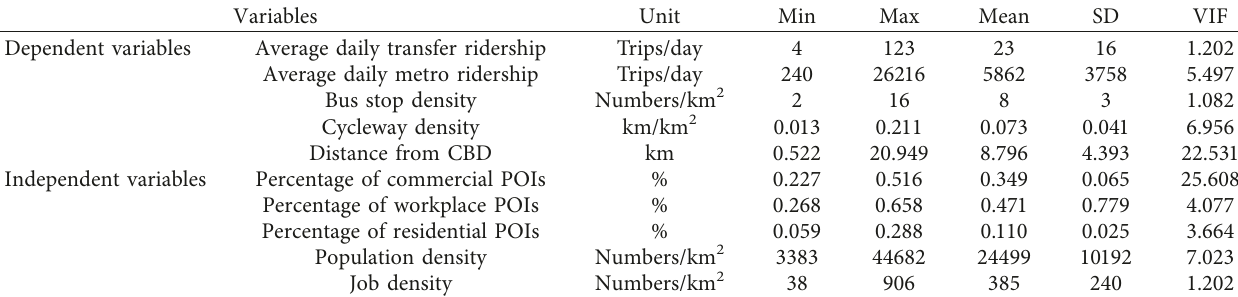
Table 1: Descriptive statistics of